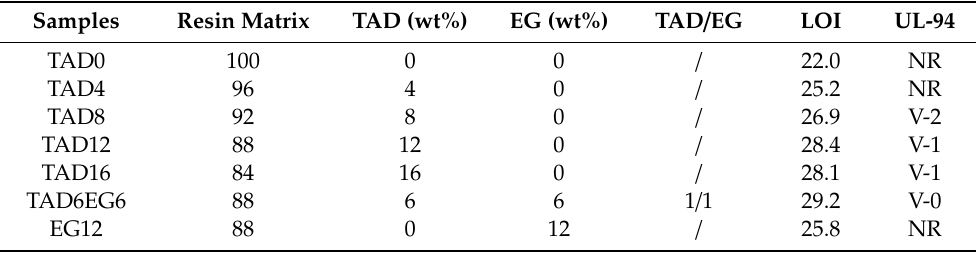
Table 1. Sample codes, formulations, LOI, and UL-94 test results of PBT / PET blend and flame-retarded PBT / PET